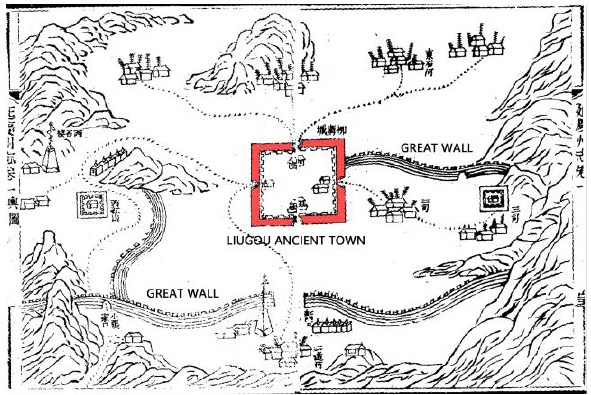
Figure 2. Ancient map of Liugou